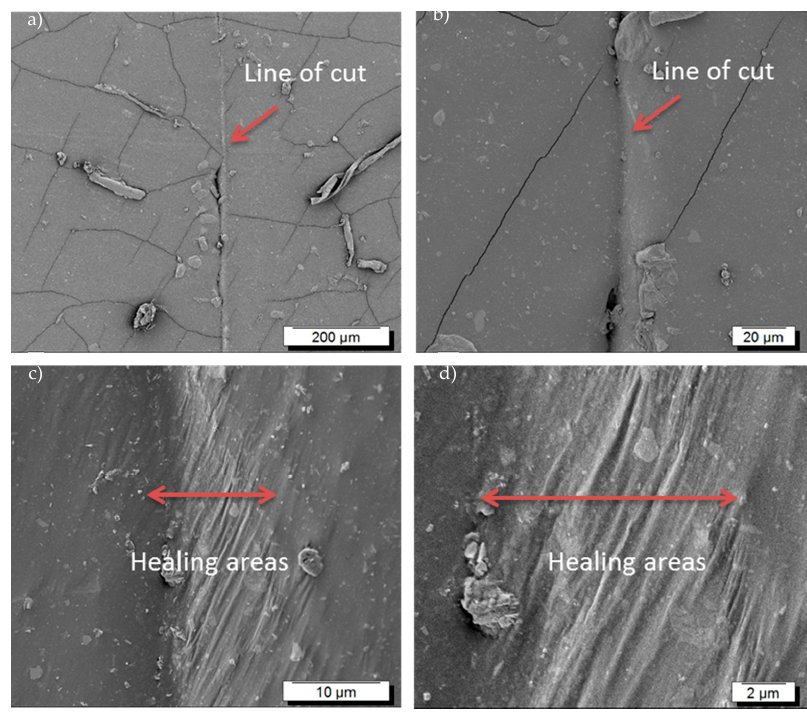
Figure 2. Scanning electron microscopic pictures of imidazole modified BIIR rubber. The samples were cut into two pieces ( a ) and allowed to heal for 24 h ( b – d ).